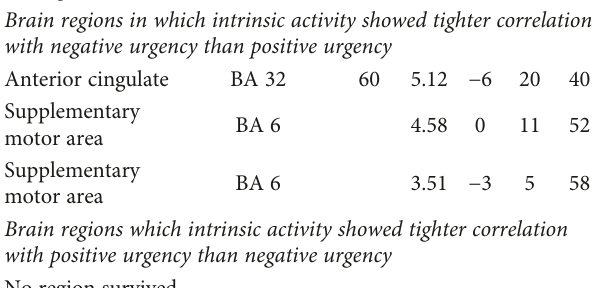
with positive urgency than negative urgency No region survived Note: BA=Brodmann